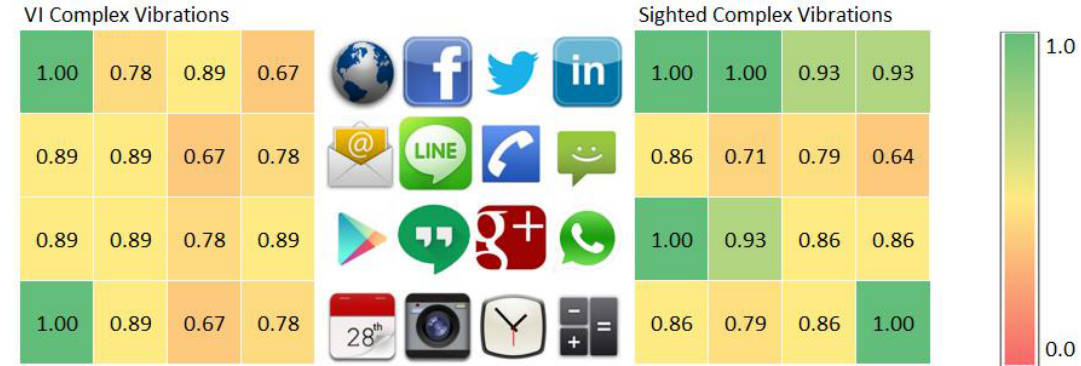
Figure 10. Heatmap recognition rate per haptic icon for VI ( left ) and sighted ( right ) people using complex vibration patterns. The haptic icons’ locations are represented in the ( center ) of the figure.